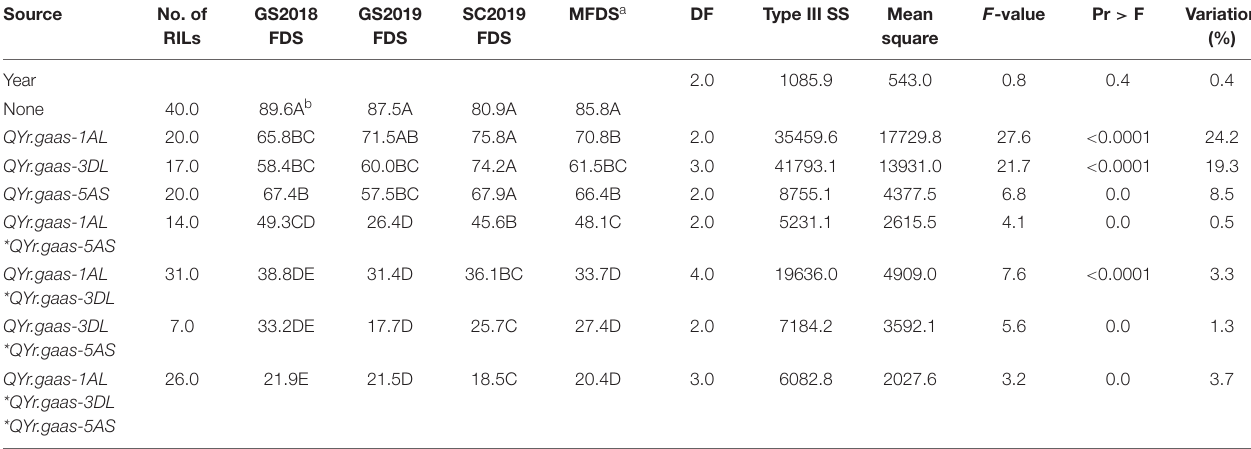
TABLE 4 | Three-way factorial analysis of variance (ANOVA) of final disease severity (FDS) for stripe rust (YR) resistance loci, using years as blocks. Source No. of